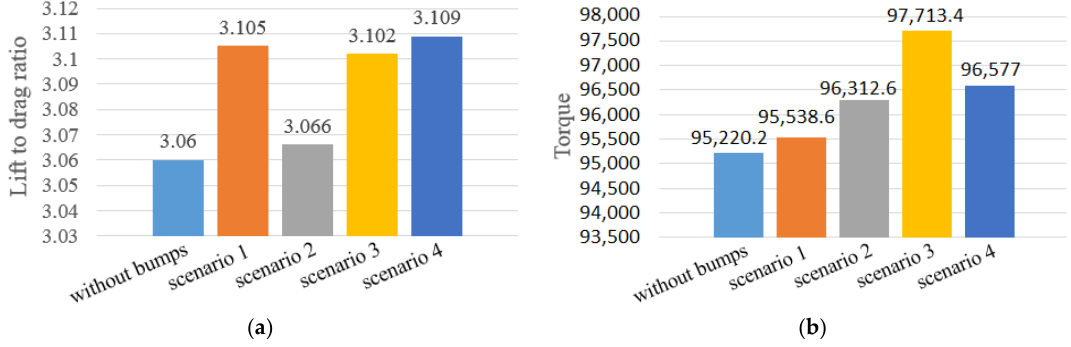
Figure 10. The influence of surface bumps on the lift and drag forces and rotor torque. ( a ) Ratio of F L / F D ( b ) Torque T